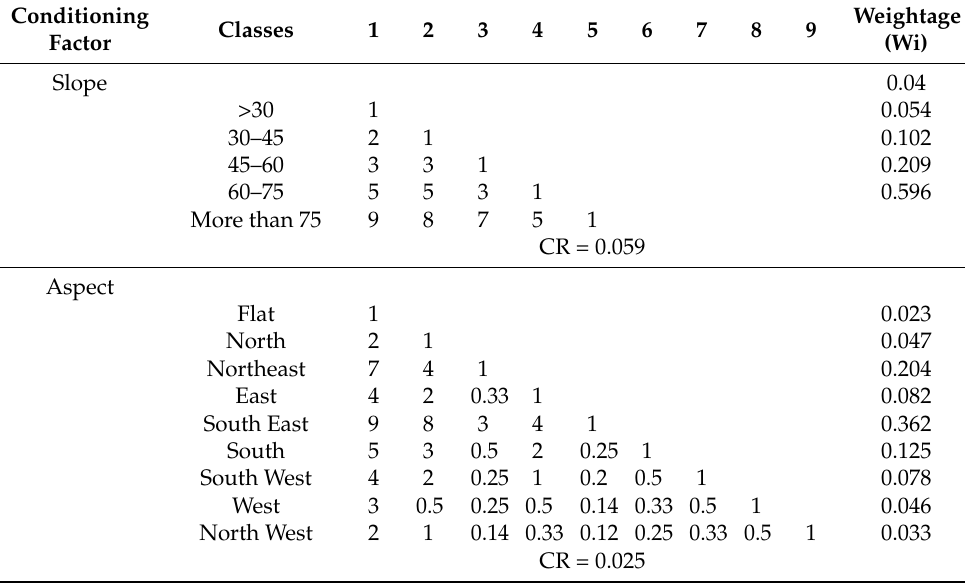
Table 4. Analytic hierarchy process (AHP) weightage and relative importance of